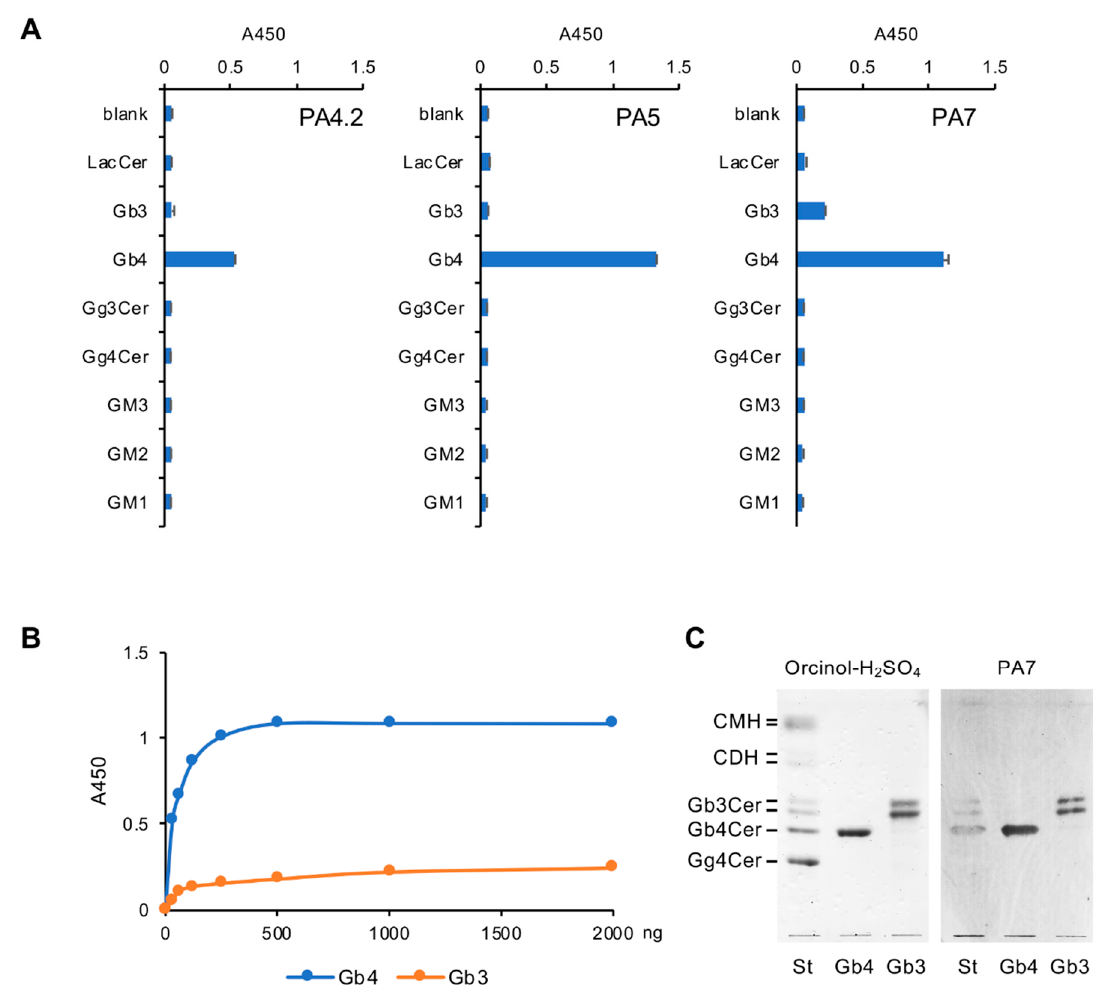
Figure 4. Characterization of monoclonal antibodies generated from a Gb4Cer-VLCFA-immunized mouse. ( A ) Reactivity of monoclonal antibodies (mAbs) PA4.2, PA5, and PA7 against several GSLs, evaluated by ELISA. The wells of a 96-well microtiter plate were coated with 500 ng of each GSL and then reacted with each mAb at a concentration of 2 µ g / mL. The structures of the GSLs are summarized in Table 3. ( B ) Reactivity of mAb PA7 against various concentrations of Gb4Cer (Gb4) and Gb3Cer (Gb3), evaluated by ELISA. ( C ) Thin-layer chromatography (TLC)-immunostaining of Gb4Cer using PA7. The double band found in Gb3Cer is due to the difference in the lipid structure. Left panel, orcinol-H 2 SO 4 staining. Right panel, immunostaining with PA7. St, standard glycosphingolipids mixture; Gb4, Gb4Cer; Gb3, Gb3Cer; CMH, ceramide monohexoside; CDH, ceramide dihexoside.